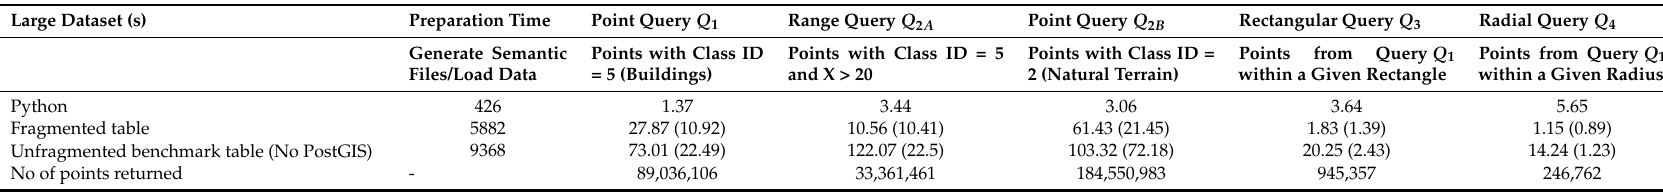
Table 6. The preparation time along with the query times for five queries using the LARGE dataset. Quering using SDBL via Python is still the fastest approach for the simple queries Q 1 , Q 2 A and Q 2 B . All times are in